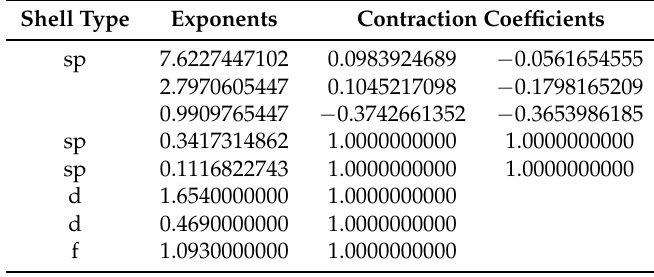
Table A9. Parameters of the cc-TZVP basis set of Nitrogen. Parameters taken from [80].